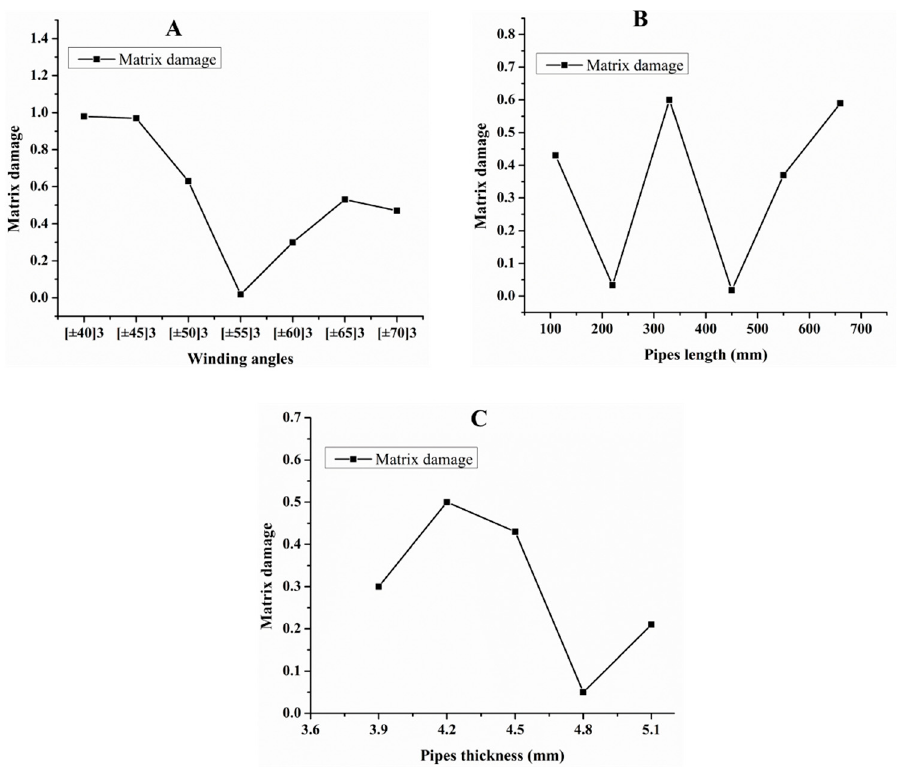
Figure 7. Matrix tensile damage (DAMGEMT) of GFRP composite pipes with varied winding angles ( A ), thicknesses ( B ), and lengths ( C ). ( A ), thicknesses ( B ), and lengths ( C